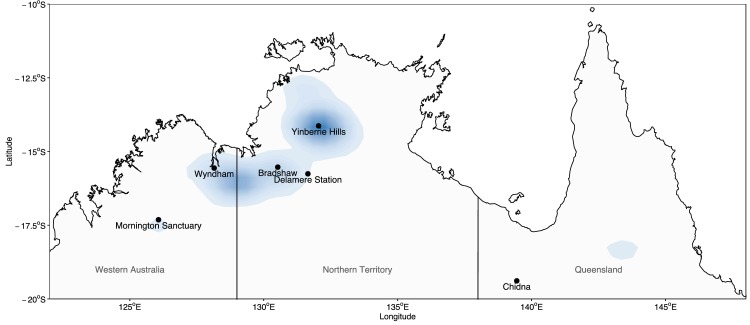
Map of the north of Australia, showing the locations blood samples were collected between 2004 and 2013.Heat map indicates the density of Gouldian finch presence data from Atlas of Living Australia [20] since trapping became illegal in 1987, where darker blue indicates high occurrence density. Background map reprinted from [22] under a CC BY 4.0 license, with permission from the Australian Bureau of Statistics, Original Copyright 2011.